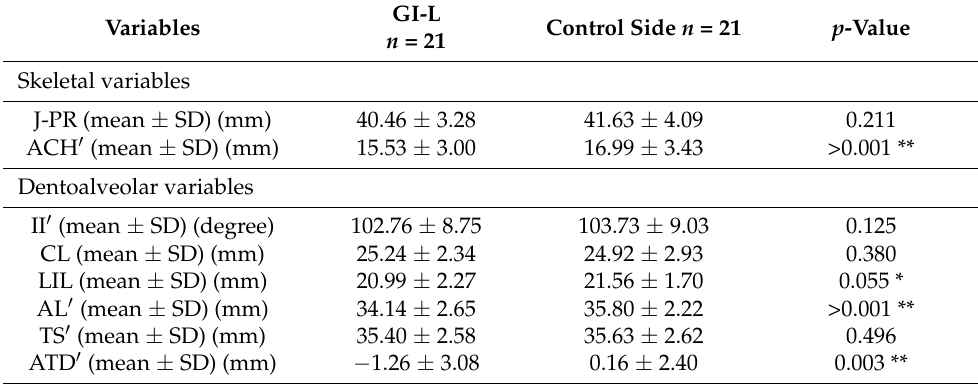
Table 5. Comparisons according to the left side (GI-L) vs. control side (GC ´ ) of impaction of the skeletal and dentoalveolar variables ( n =